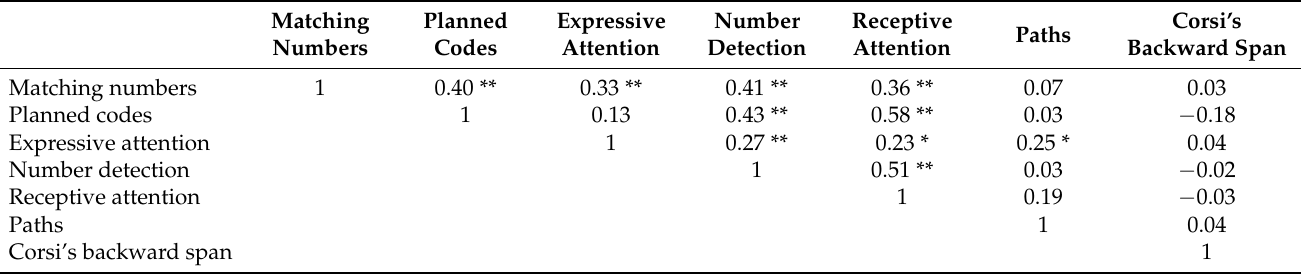
Table 2. Correlation analyses between attention and visuo-spatial working memory skills variables in 2nd and 3rd grades, first data collection overall: Pearson’s linear correlation coefficient ( N = 112).